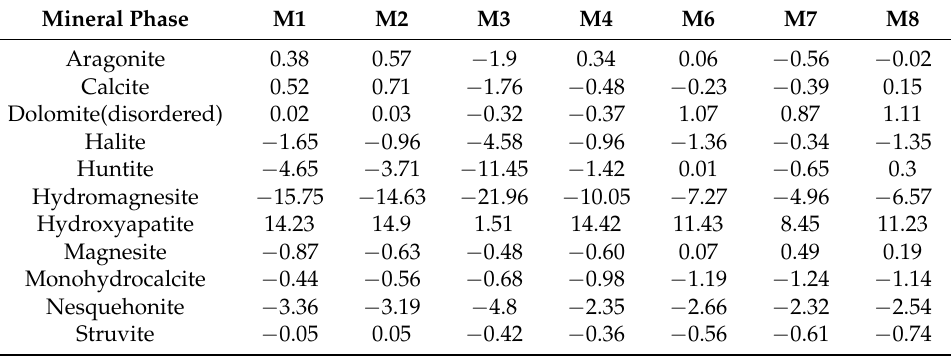
Table 4. Initial saturation index values of different minerals in the experimental media at 30 ◦